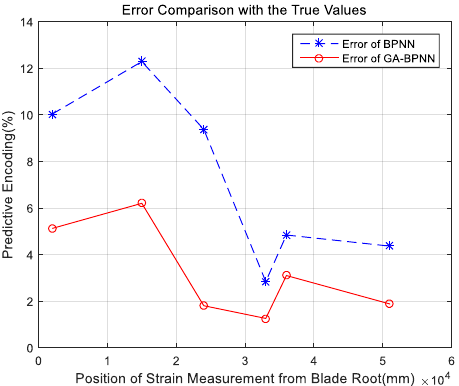
Figure 7. The comparison results of prediction errors for the center of suction side.